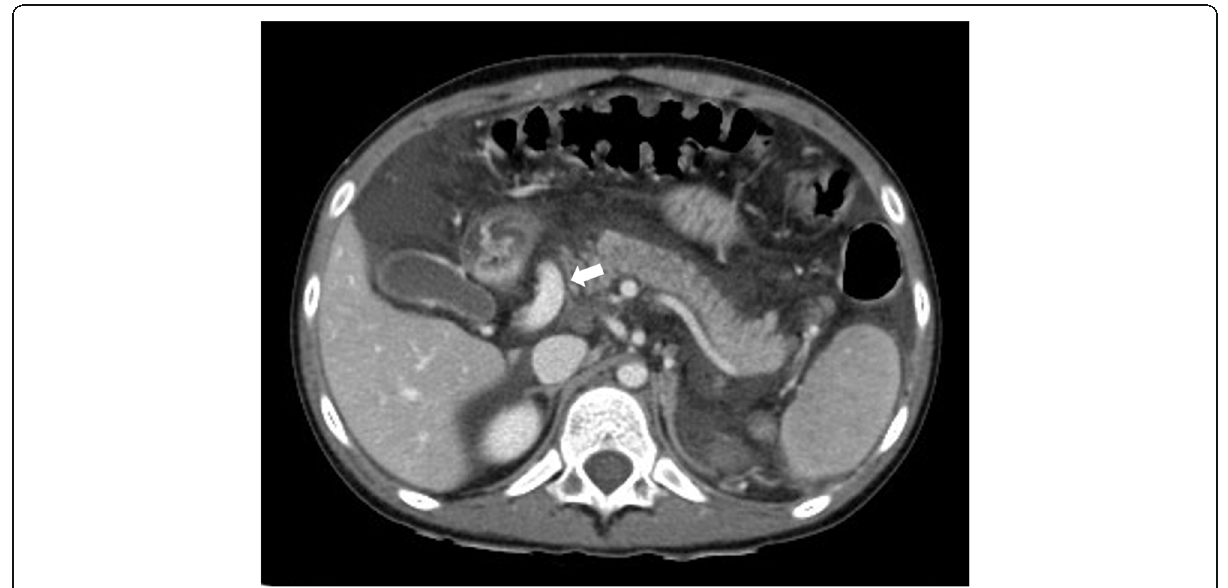
Fig. 1 CTA of a 8-year old female who presentend with hematemesis due to variceal bleeding. Axial CT image in the portal venous phase shows an aberrant mesenteric retroduodenal venous collateral